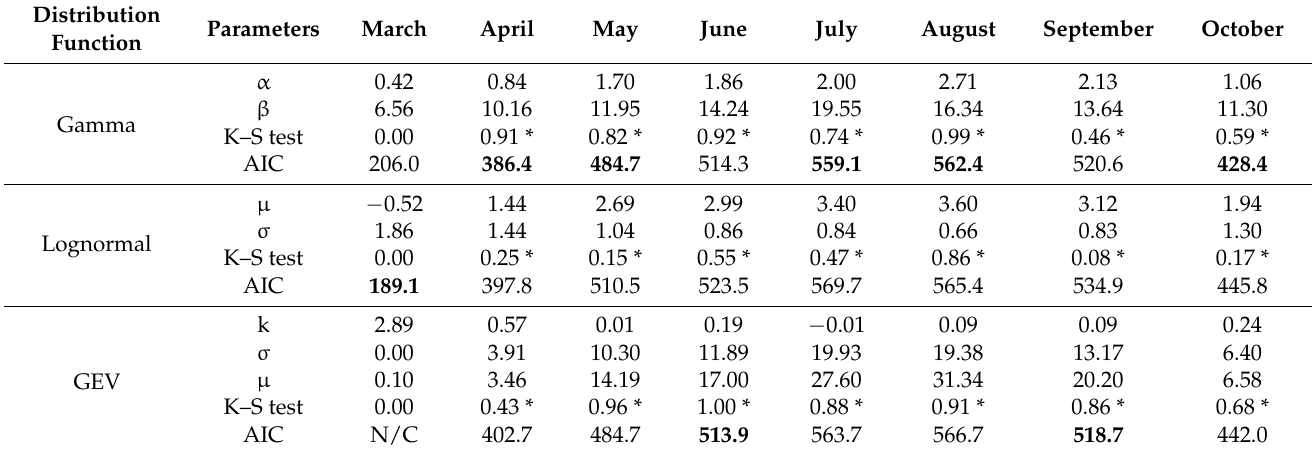
Table 2. Parameters of marginal distribution for monthly precipitation.